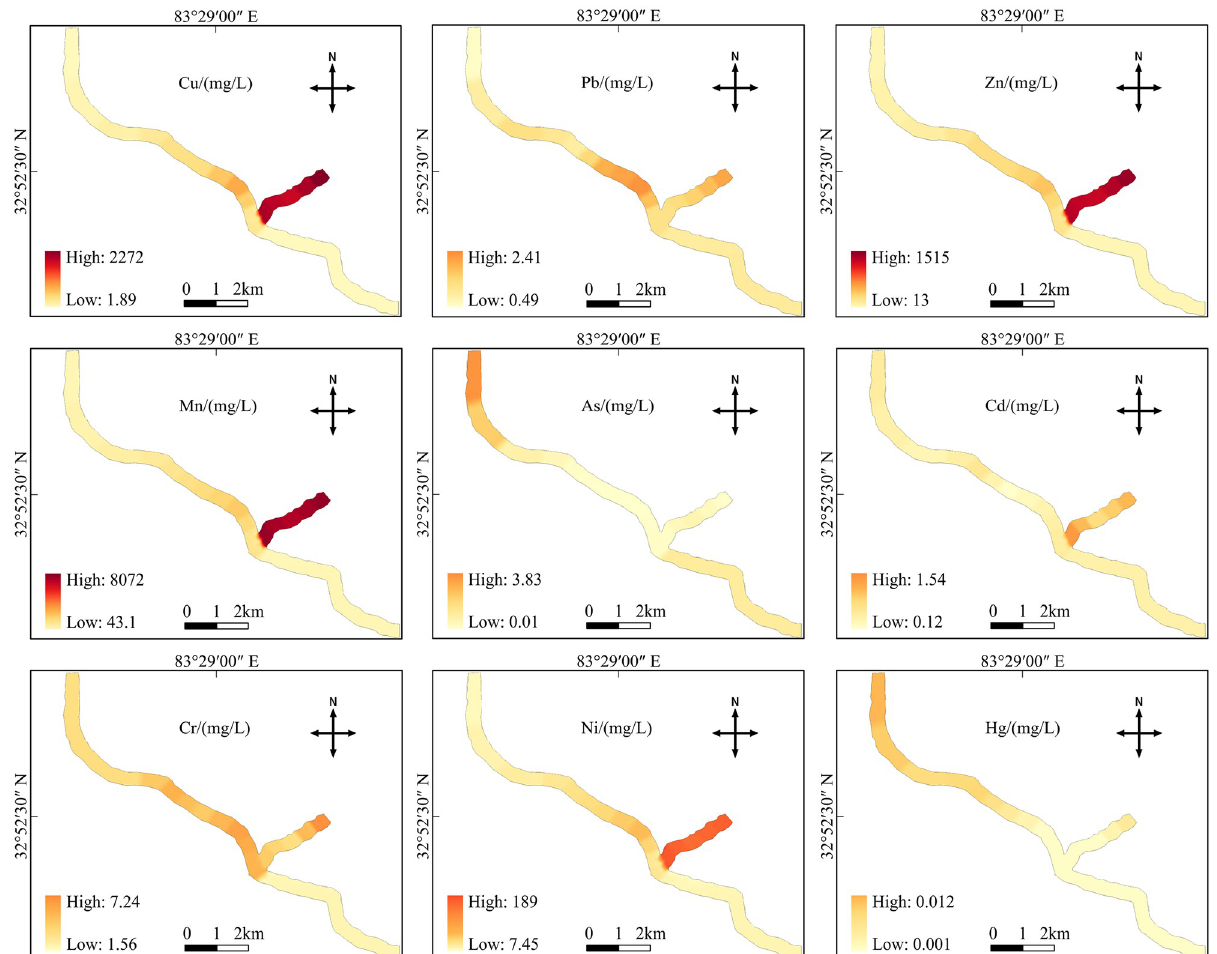
Fig 3. Spatial distribution of heavy metals in the Rongna River water. The location coordinate map of the study area was drawn according to the USGS National Map Viewer.